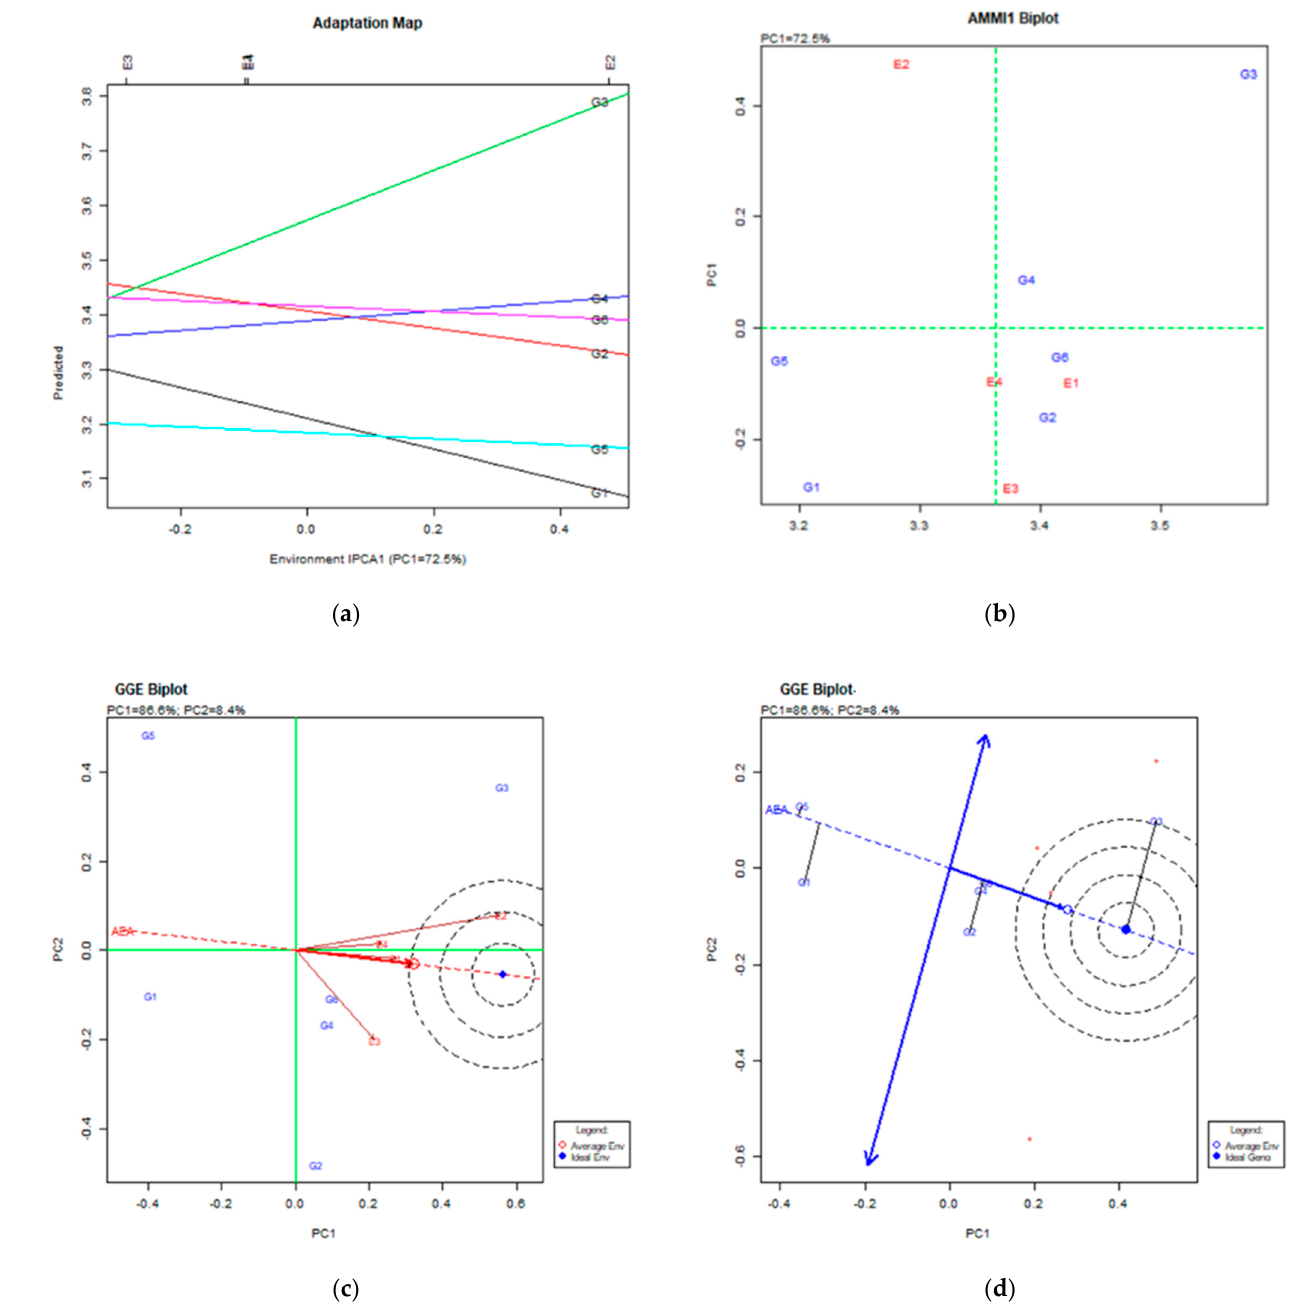
Figure 5. Stability analysis for the number of stems per plant based on: ( a ) the adaptation map where the X-axis (PC1) visualizes the stability of varieties over environments and the Y-axis—the performance of varieties for the trait; ( b ) the AMMI1 biplot where the Y-axis is the one visualizing the trait performance and the X-axis (PC1) visualizes the stability of varieties over environments; ( c ) the GGE biplot for environments depicting the stability of the environments over years via the placement as near as possible to the ideal and average environment; ( d ) the GGE biplot for varieties depicting the stability of the varieties over environments where the productive varieties are those to the right on the AEA vector and the stable ones are those which are as close to the AEA axis as possible.